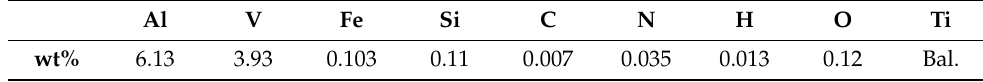
Table 1. The main chemical composition of Ti-6Al-4V.